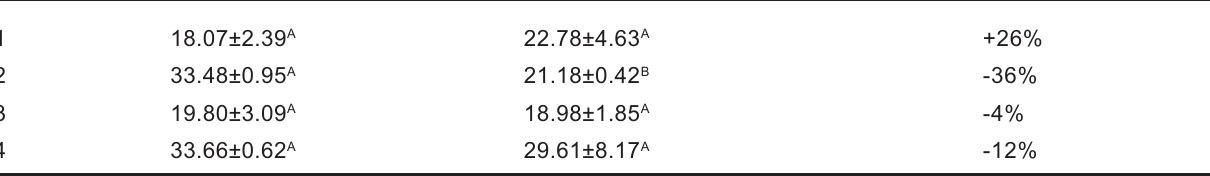
TABLE 1- Means (±SD) of the amount of phosphate released (µg) from enamel powder exposed to Sprite Zero ® containing or not carbonate as a function of the presence of iron previously exposed with the enamel powder or added directly to the